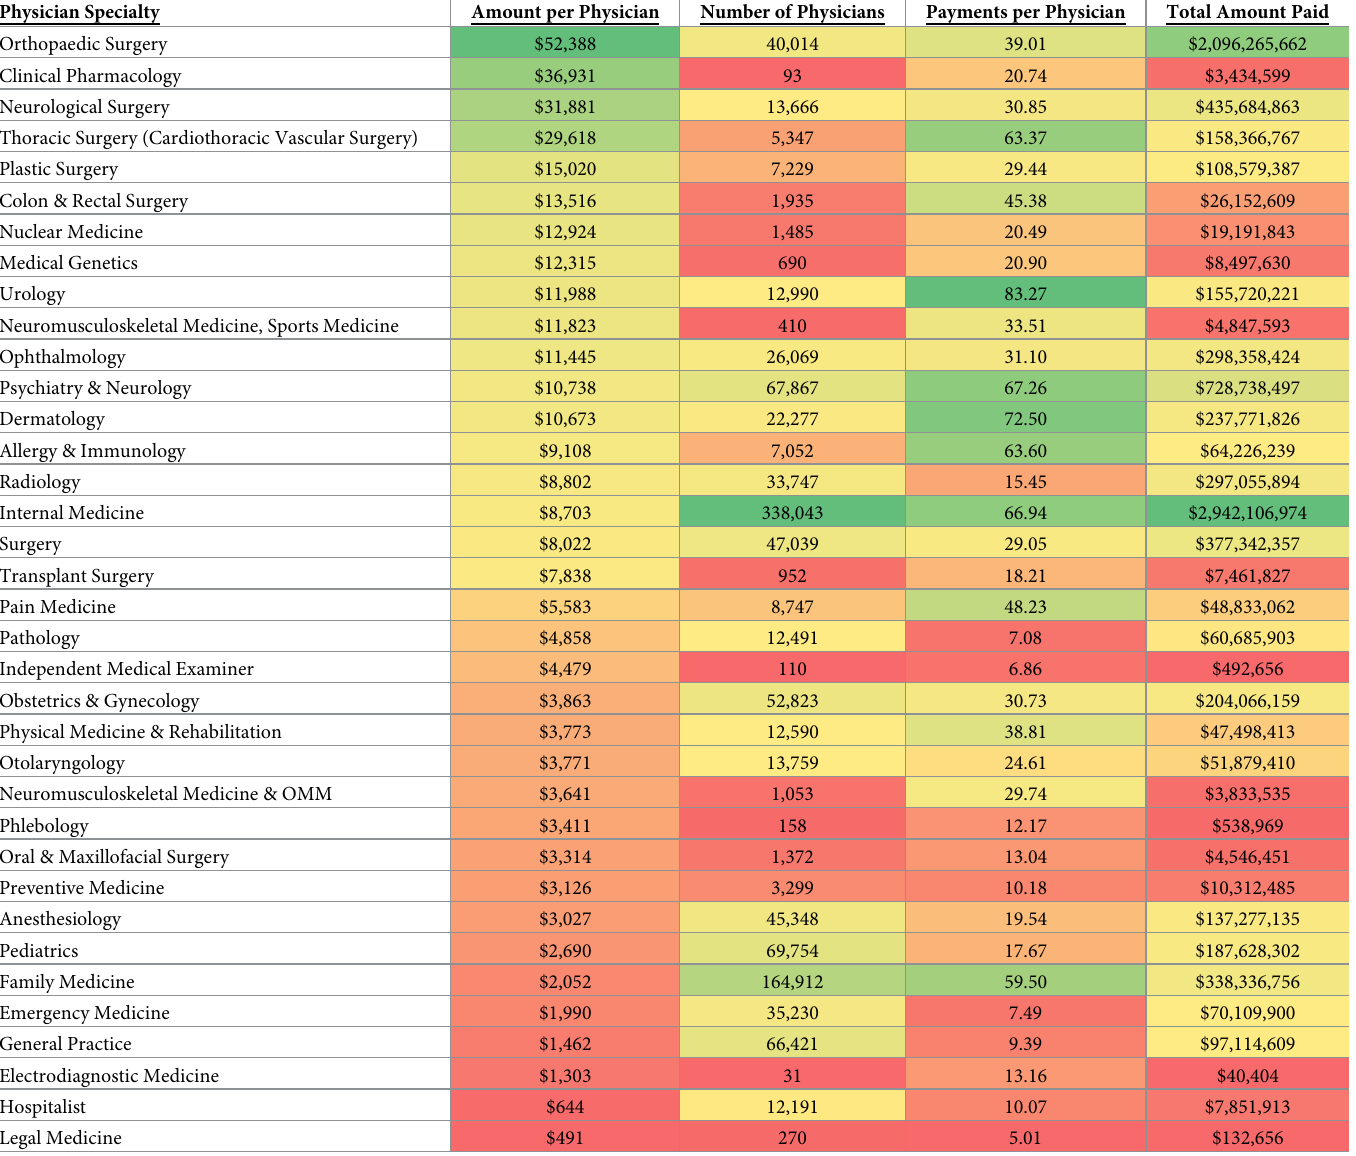
Table 1. Variability in mean payment per physician, number of physicians, and aggregated payments for transactions in the Open Payments database, 2014–2018, for each top-category specialty available for allopathic and osteopathic